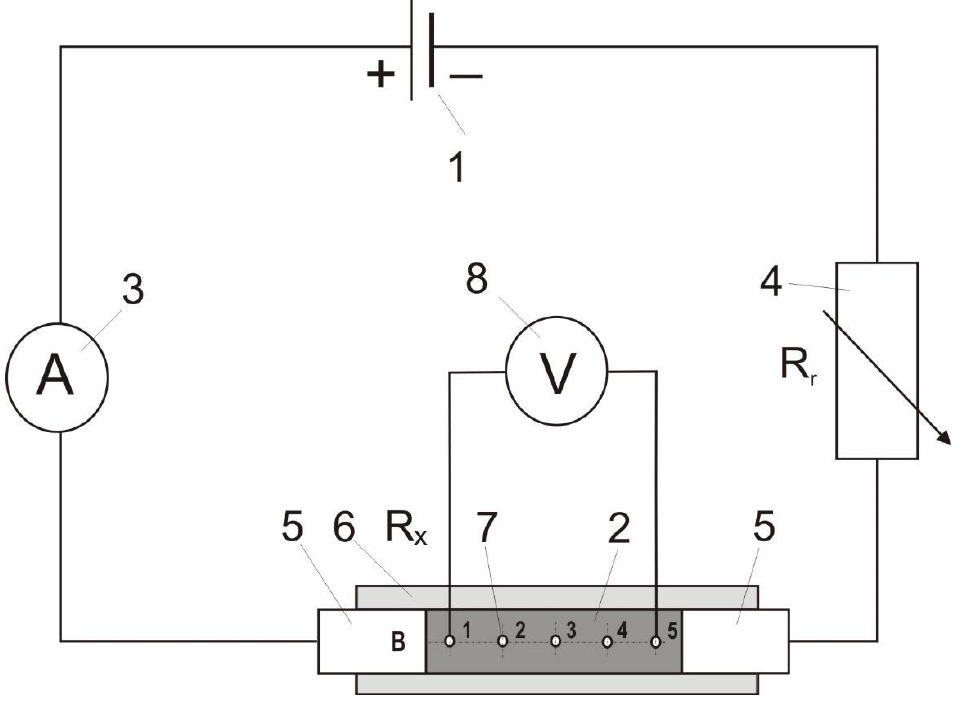
Figure 1. Measuring stand scheme.